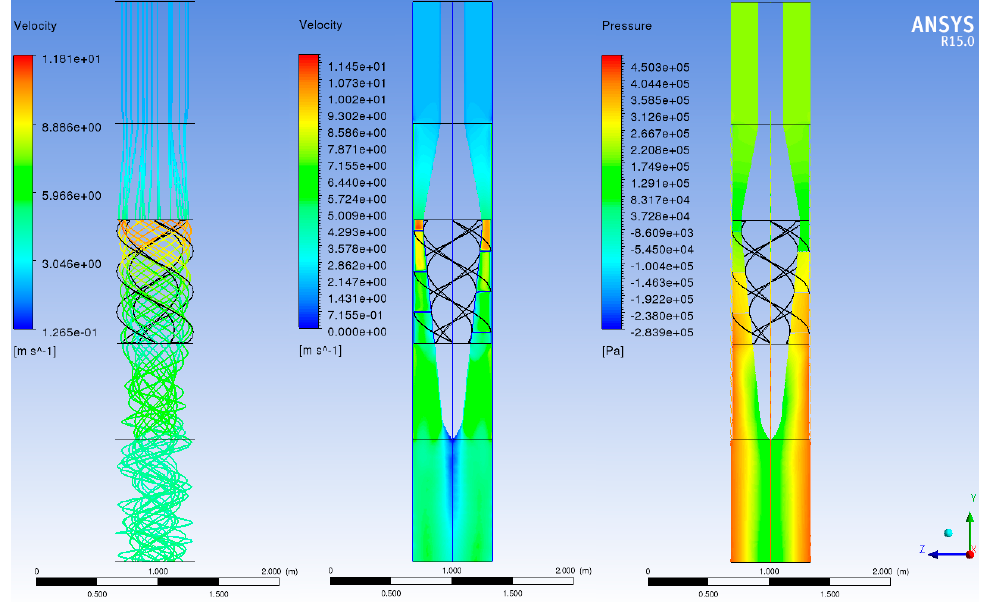
Figure 10. Optimal design of the Archimedean pump: velocity streamlines ( Left ), velocity contours ( Middle ) and static pressure contours ( Right ) on a longitudinal plane